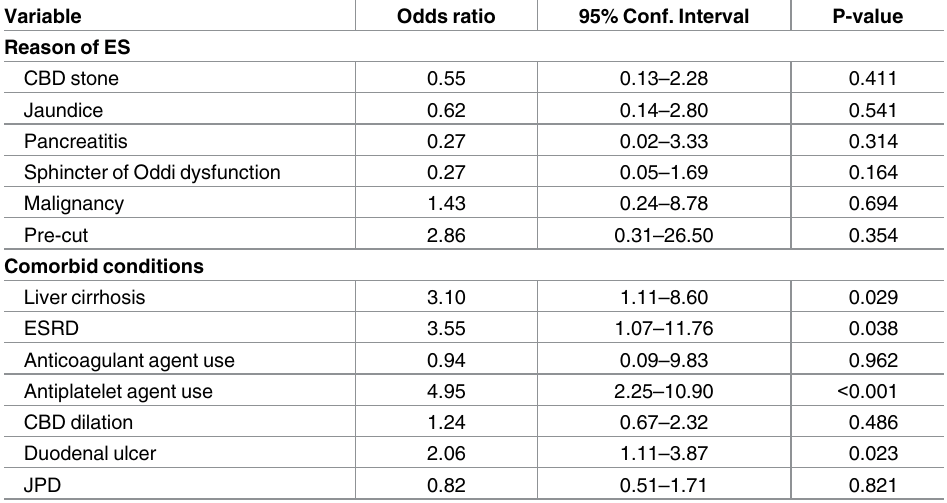
Table 2. Multivariate analysis of potential risk factors for post-endoscopic sphincterotomy bleeding.